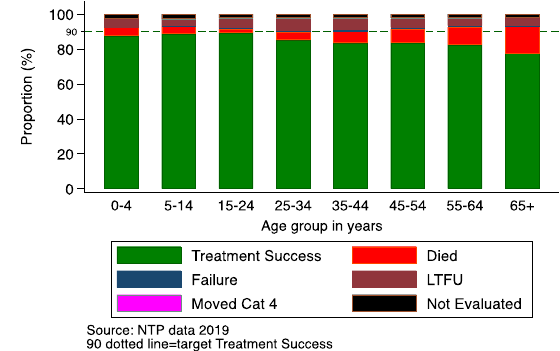
Fig. 1 Treatment outcome by age groups for TB patients notified in 2019 in Kenya (Program-NTLLD-P NTLaLD